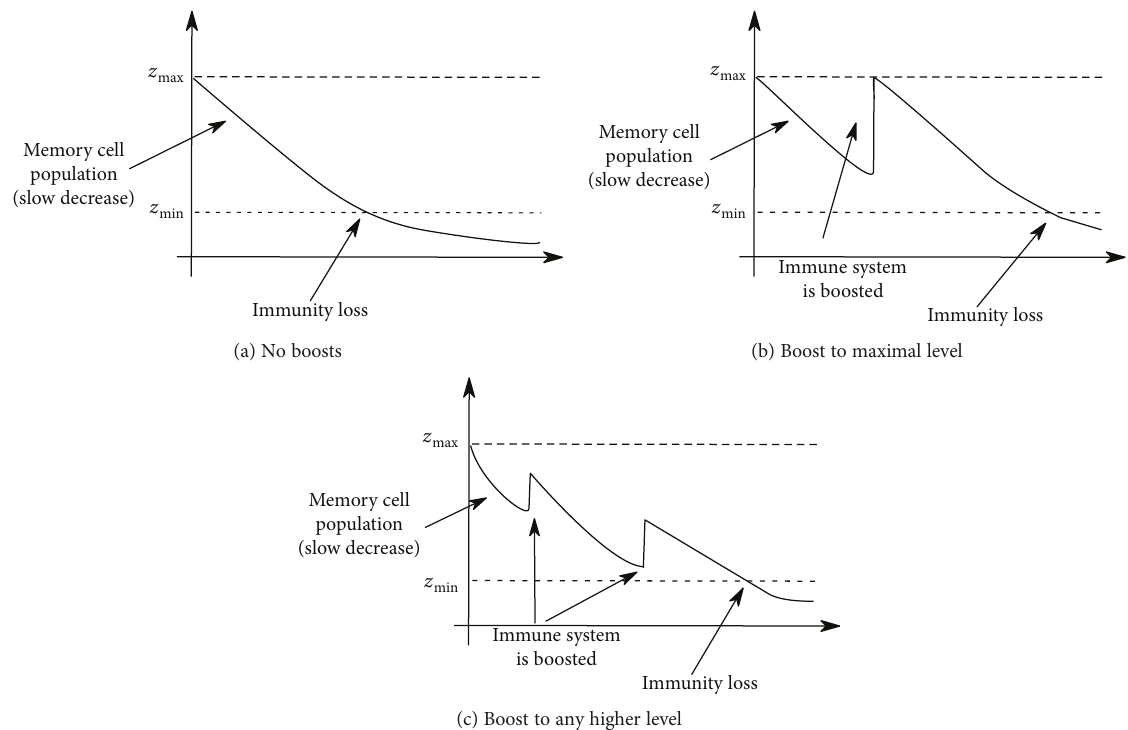
Figure 2: Exposure to the pathogen has a boosting e ff ect on the immune system, whereby several possible scenarios are possible: (a) No boosting events (NOboost): the host who recovered at time t becomes susceptible at time t + τ , with τ > 0 given in (2). (b) Boosts restore disease-induced immunity, that is, the immune system is always boosted to the maximal level of immunity (MAXboost). (c) Variable boost, to any higher immune